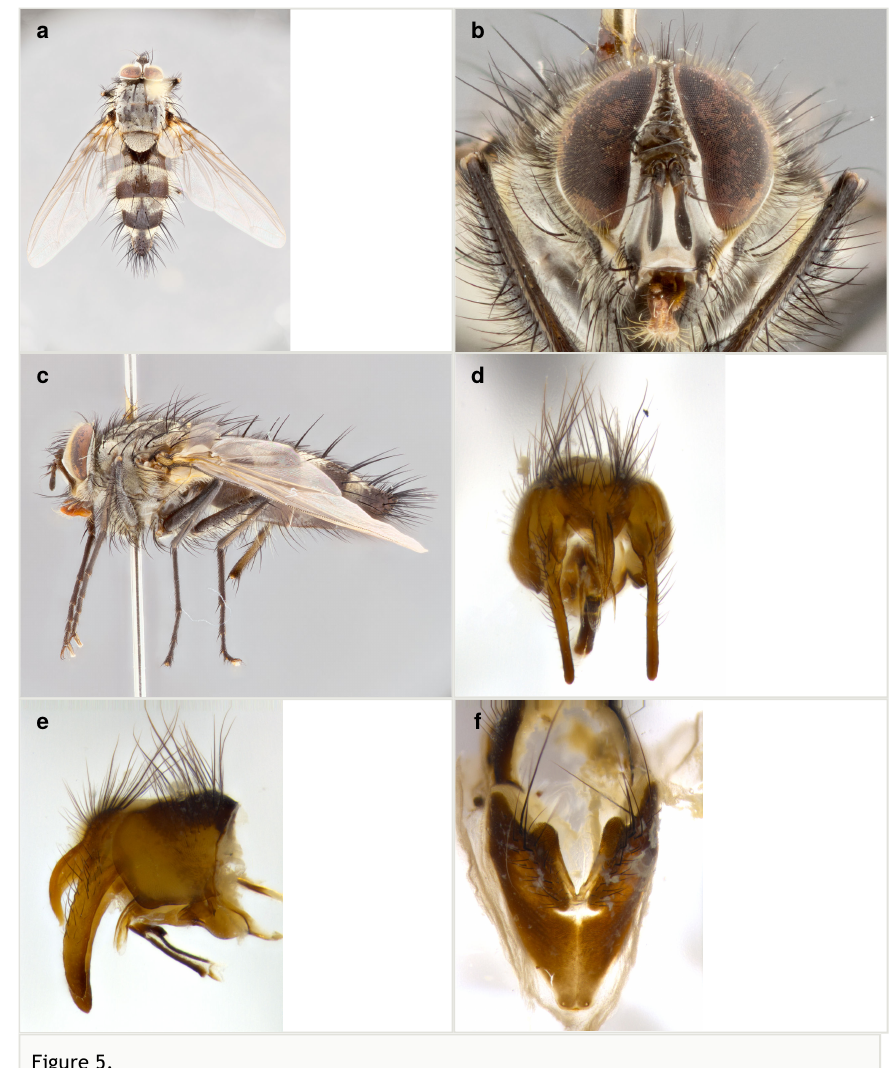
Uramya constricta sp. nov. ; a-c : holotype male; voucher n. DHJPAR0018567; d-f : paratype male; voucher n.